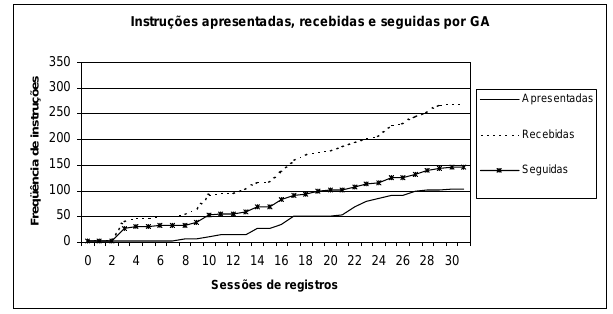
Figura 5 . Freqüência acumulada de instruções apresentadas, recebidas e seguidas por GA no período de Levantamento de Repertório de Entrada (sessão 0) e ao longo das 31 sessões de coleta de